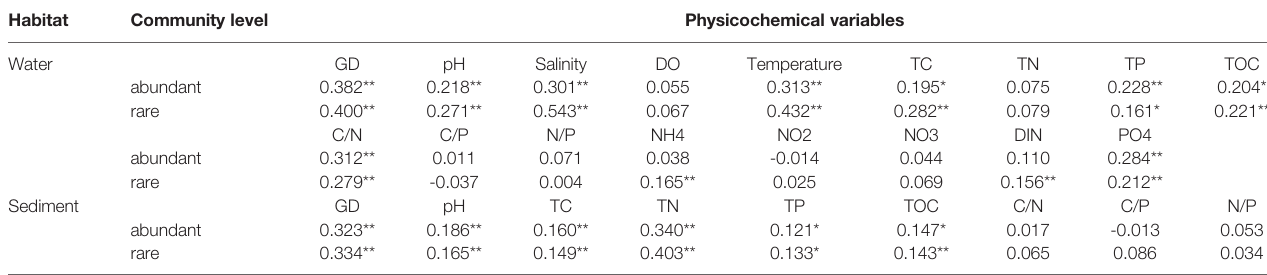
TABLE 2 | The Mantel test results of physicochemical variables against the microbial community structure of abundant and rare taxa of water or sediment habitat. . Habitat